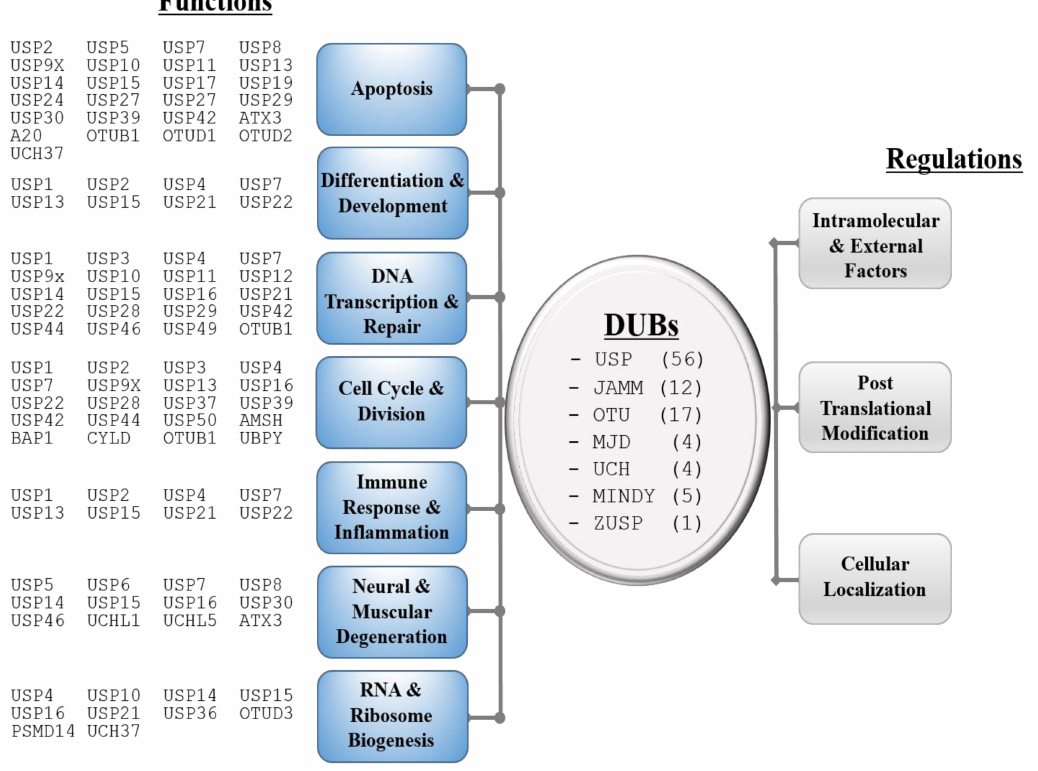
Figure 1. Diverse functions and regulations of deubiquitinating (or deubiquitylating) enzymes (DUBs). DUBs are grouped into seven categories based on their